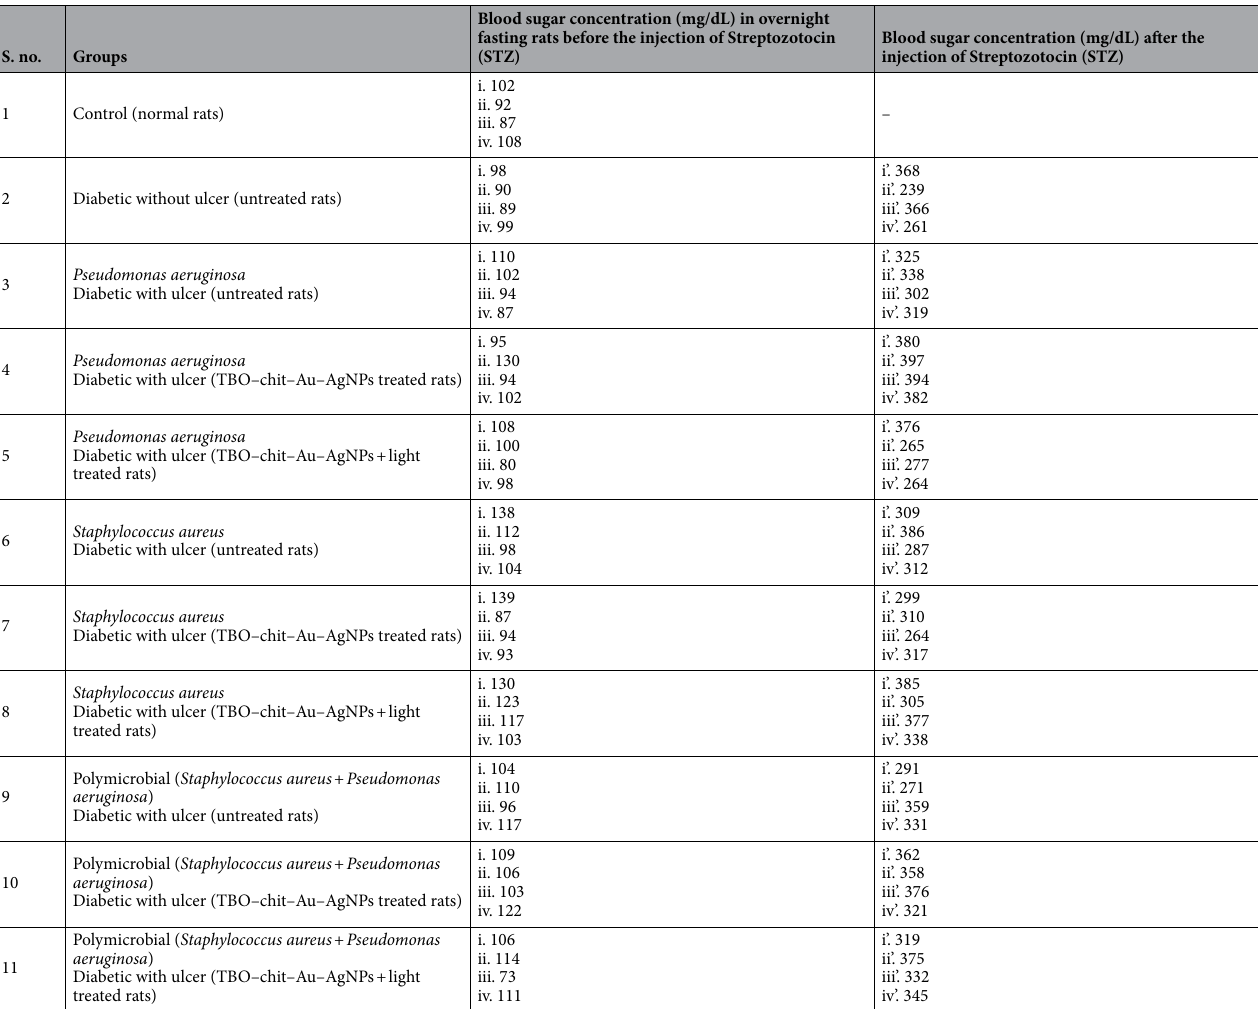
Table 2. Experimental induction of type-2 diabetes by streptozotocin (STZ)